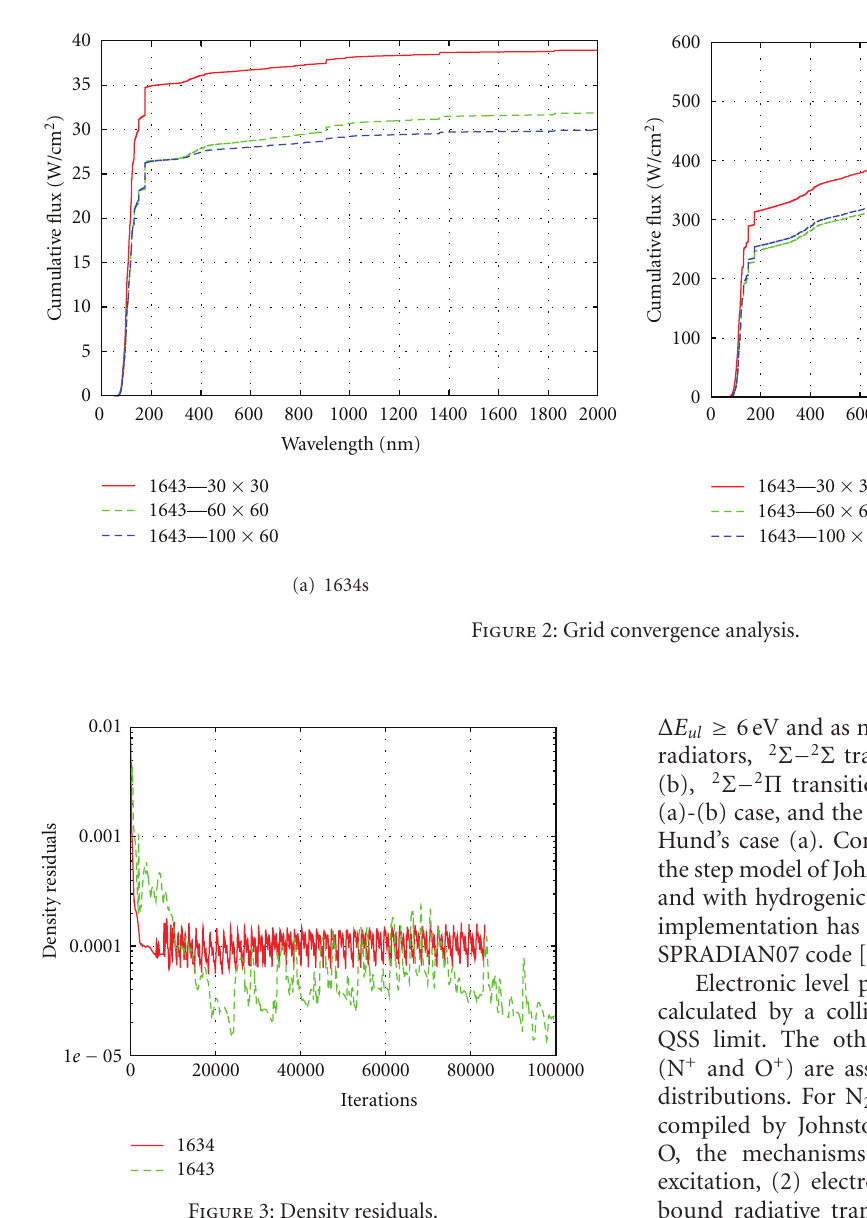
Figure 3: Density